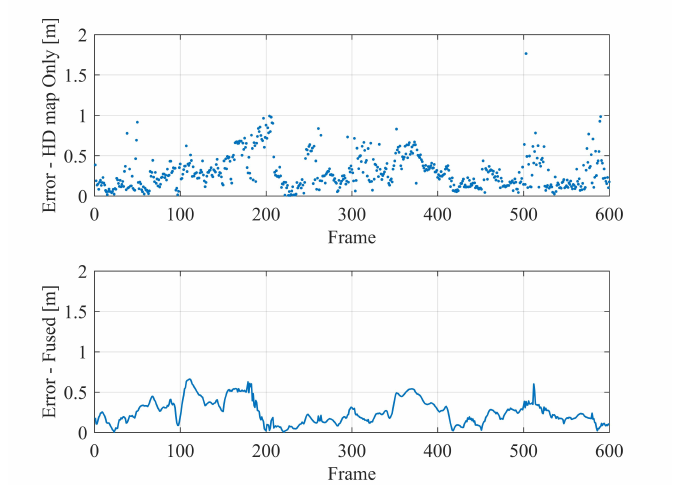
Figure 17. Vehicle localization results in the scenario 2—top: positioning errors of map-based localization; bottom: translation errors after fusing frame-to-frame